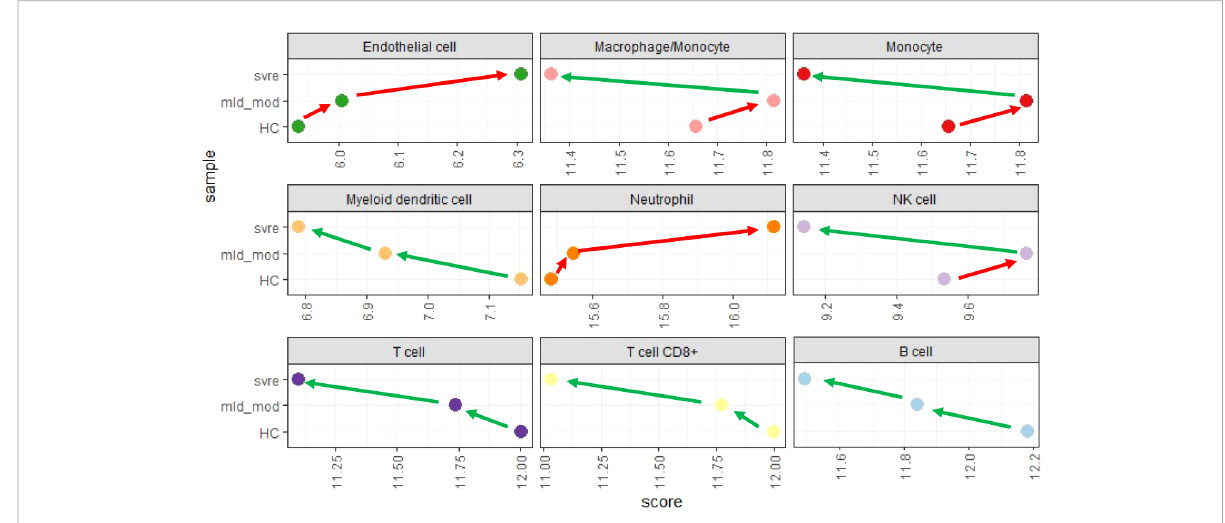
FIGURE 9 Deconvolution analysis. Mean values for mild/moderate, severe and healthy control groups were calculated and subjected to deconvolution analysis. Y-axis: severity categories, X-axis: scores from mcp_counter analysis for the different cell populations. Abbreviations: HC stands for healthy controls; mld_mod stands for mild and moderate; svre stands for